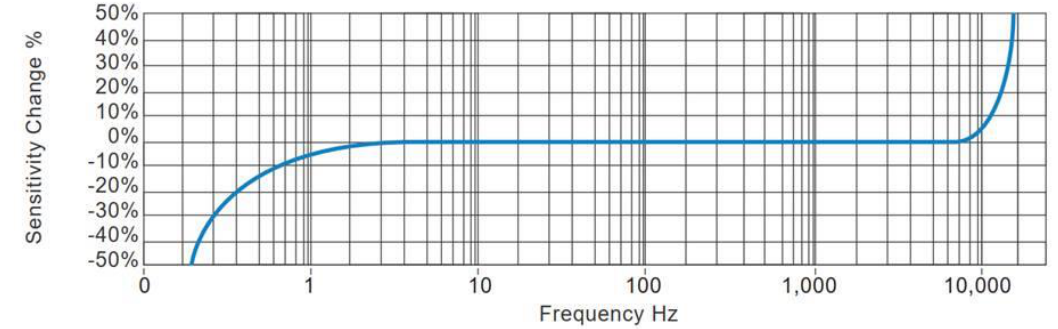
Figure 9. The typical frequency response of accelerometer by Hansford sensor Co., Ltd.